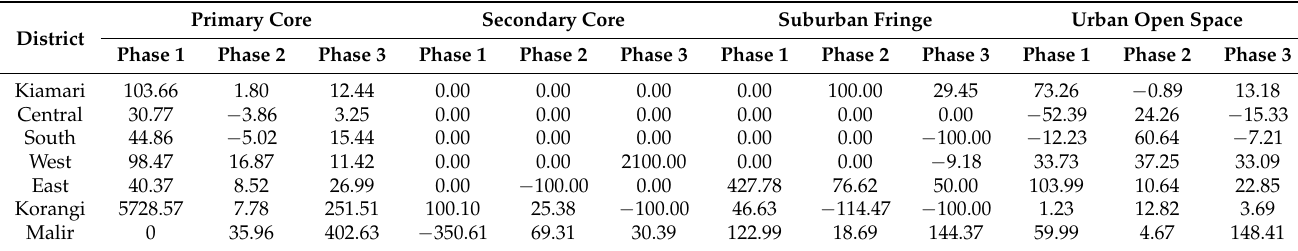
Table 7. Urban landscape changes in different districts of Karachi (in percentage).